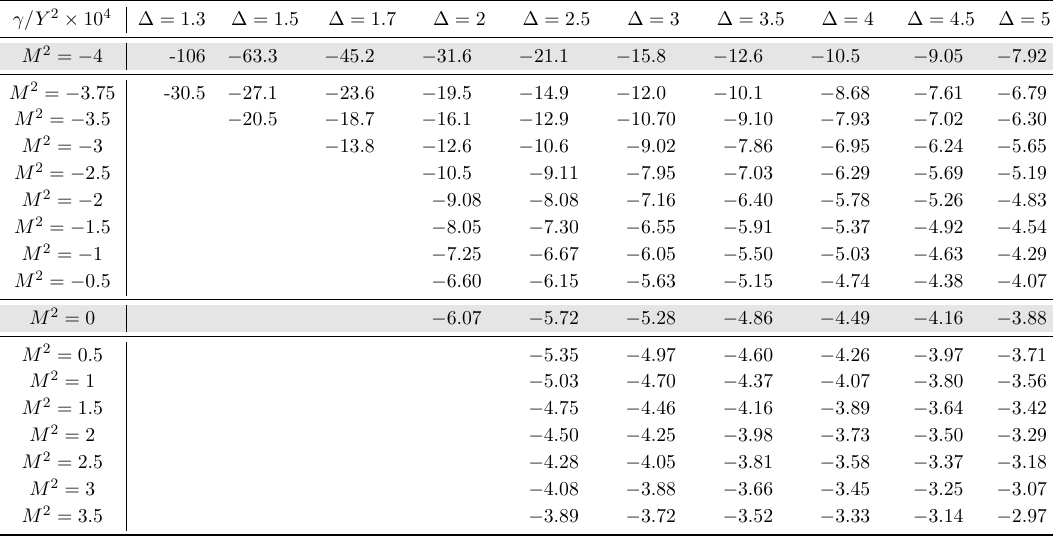
Table 2 . Binding energy contributions from scalar exchanges of different mass M . These results correspond to solutions χ satisfying (3.33). Missing values do not satisfy this condition. We have (1) highlighted rows corresponding to analytic results, obtained for M 2 = (0 , − 4) .